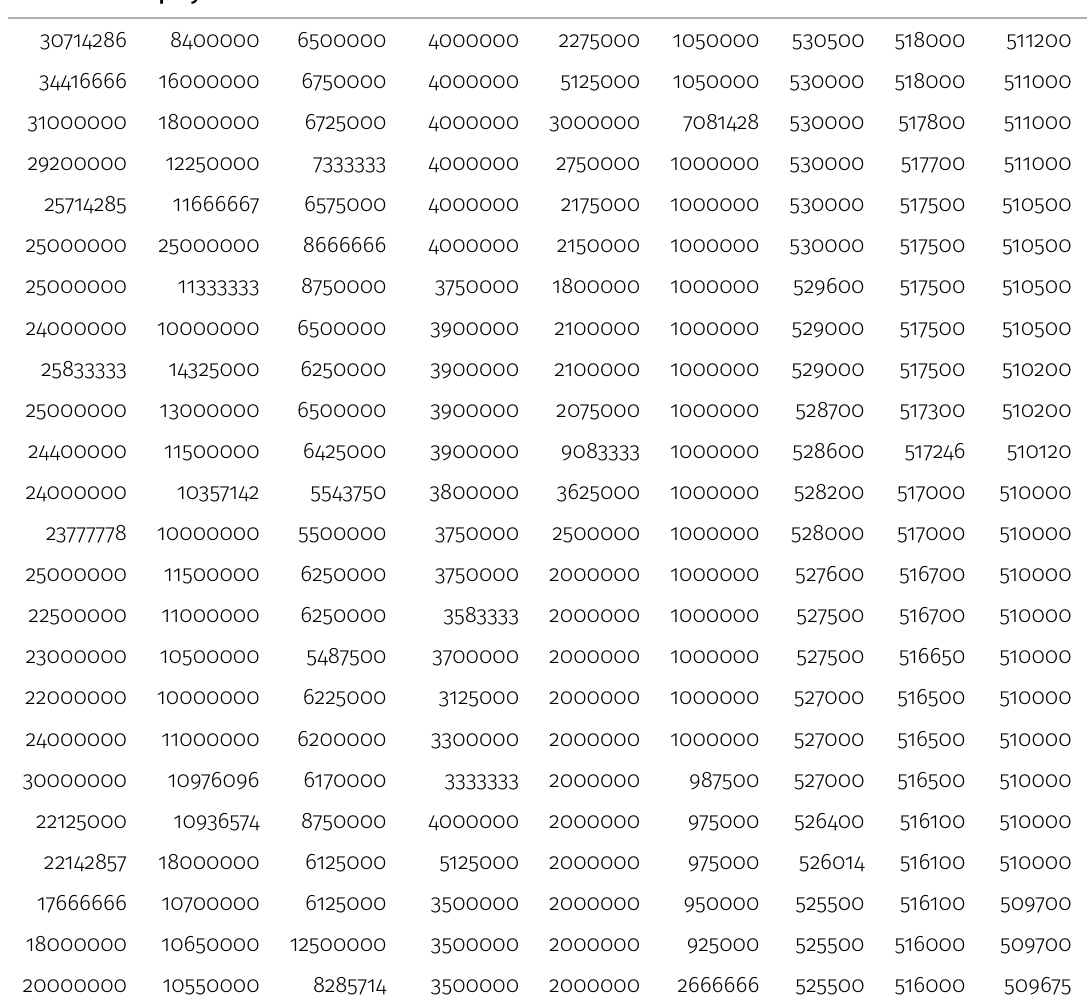
Table A.II. Baseball players salaries